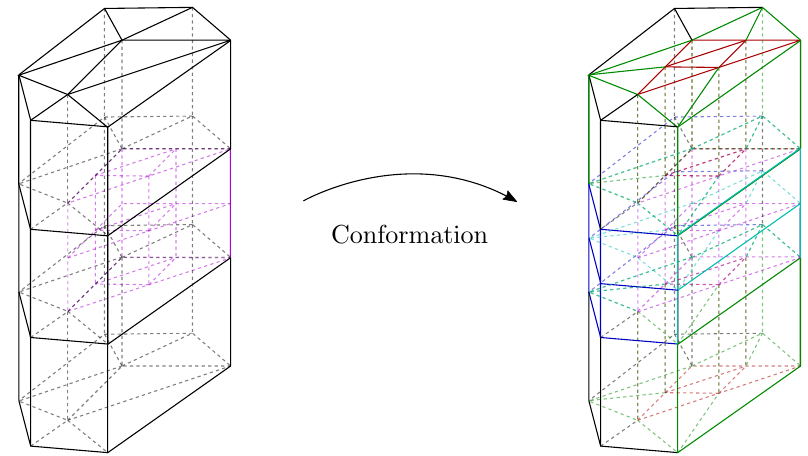
Figure 2. An example of application of conformation process in refined